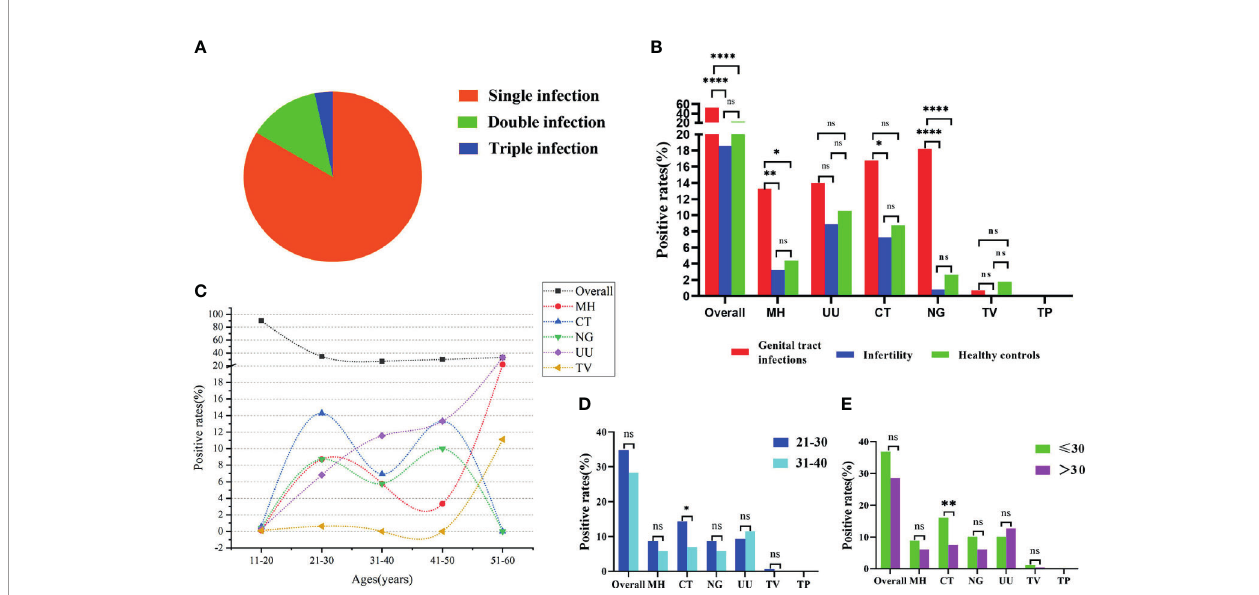
FIGURE 5 | Analyses of clinical data based on Sexually transmitted infections high-throughput multiplex gene detection system (STI-HMGS). (A) STI-HMGS assays of the 123 con fi rmed STI patients showed that 83.7% of patients had a single infection, 13.0% had a double infection, and 3.3% had a triple infection. (B) A comparison of the positivity rates for each pathogen and the overall rate among the three groups. (C) The relationship between positive detection rates and different age groups. (D) A comparison of the infection rate between the 21-30 years group and the 31-40years group; only infections caused by Chlamydia trachomatis (CT) were signi fi cant. (E) Comparison of infection rate between the ≤ 30 years group and the >30 years group across the 381 subjects; only infections caused by CT were statistically signi fi cant. *p < 0.05, **p < 0.01, ****p < 0.0001, ns, not signi fi cant; p > 0.05.